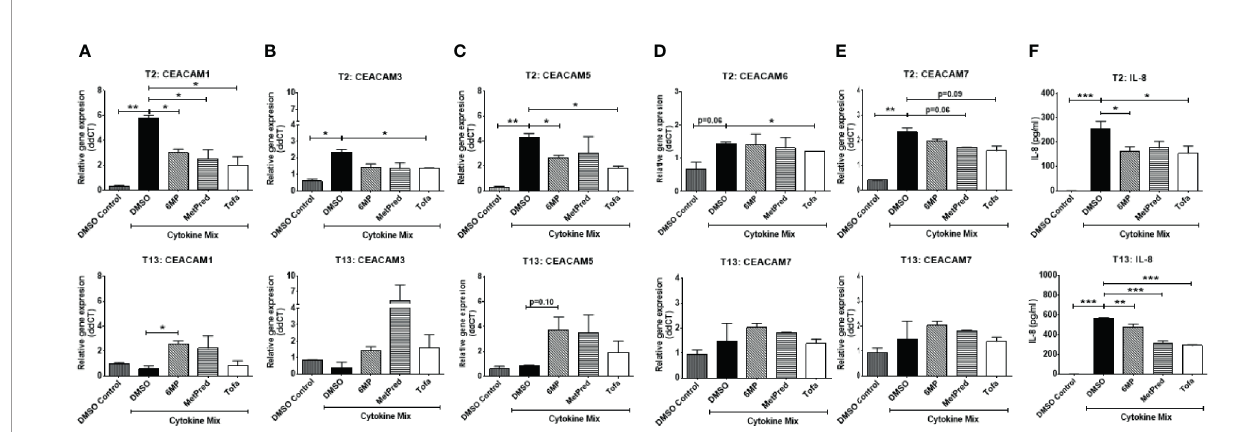
FIGURE 6 | C2BBe1 cells were pretreated for 1 h with the IBD drugs — Tofacitinib (Tofa, 10 mM), Methylprednisolone (MetPred, 10 mM), Mercaptopurine (6-MP, 5 mM) — followed by culture for 3 h with the pro-in fl ammatory cytokine cocktail (Cytokine Mix), containing recombinant human (rh) TNF- a (20 ng/ml), rh IFN- g (10 ng/ml), rh IL-1 b (10 ng/ml), and untreated. After the 3 h co-culture, cells are washed in medium followed by further culture in full culture media containing respective IBD-drug for 2 (T2) and 13 (T13) h. Control wells (DMSO Control) are treated with 0.1% DMSO. Samples are collected at T2 and T13 time points for analysis on gene expression of (A) CEACAM1, (B) CEACAM3, (C) CEACAM5, (D) CEACAM6, (E) CEACAM7 as determined by RT q-PCR and (F) IL-8 determined by ELISA. Graphs are representative of two independent experiments with pooled triplicate samples and qRT-PCR assay performed in duplicates. b -actin was used as a housekeeping gene, and results are expressed as fold change. A Student t-test was used to analyze gene expression data. *P < 0.05, **P < 0.01, ***P < 0.001 when compared outlined